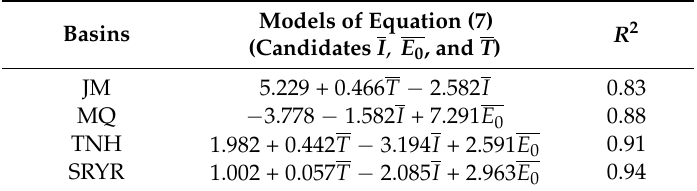
Table 2. Results of w covariate analysis for the period between 1961 and 2013.